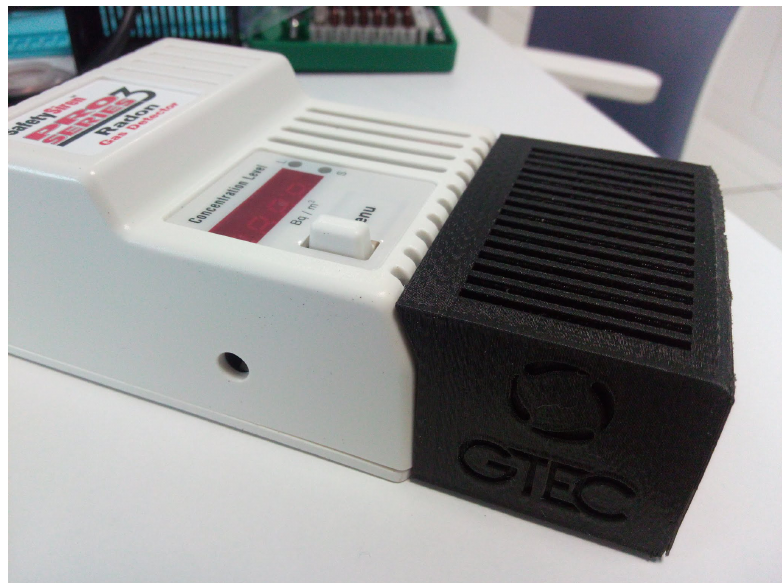
Figure 6. Radon sensor with the 3D-printed black box that contains the added